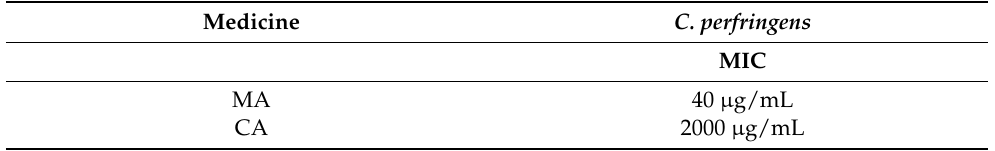
Table 2. MIC of CA and MA on C. perfringens